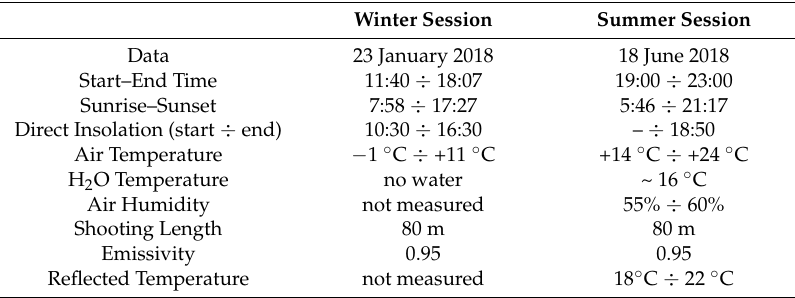
Table 1. Environmental conditions at survey